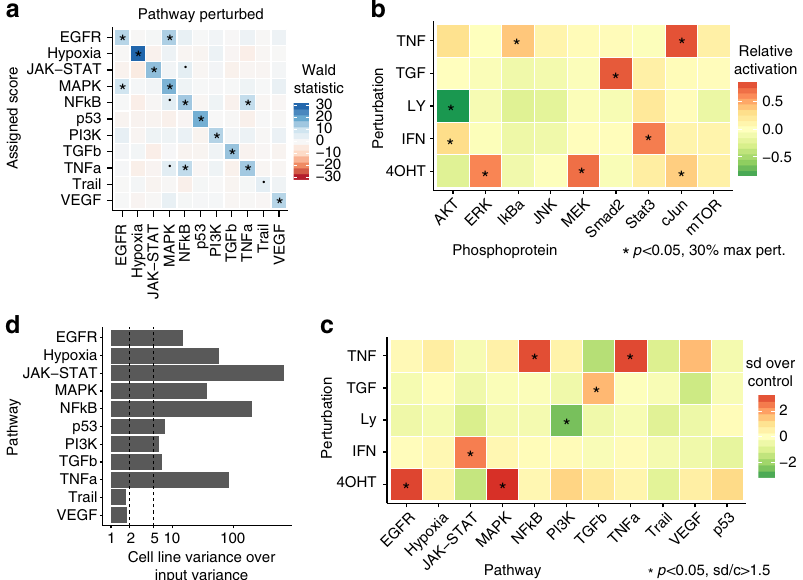
Fig. 2 Evaluation of pathway-response signatures. a Associations for PROGENy pathway scores with experimental perturbation for experiments that the model was not built with (leave-one-out cross-validation). Each pathway is strongly associated with its own perturbation, and we observe few cases of cross-talk in agreement with biological knowledge. b Pathway perturbations in HEK293 cell line activate the corresponding signaling proteins. MEK and ERK for MAPK pathway, Stat3 for Interferon-induced JAK-STAT, AKT for PI3K, Smad2 for TGFb, and IKb for TNF-alpha-induced NFkB. As expected, all increased upon stimulation except AKT that decreased upon inhibition. Activation shown relative to maximum readout per antibody, p values reported for one-sample one-sided t test. Results are signi fi cant if p < 0.05 and perturbation is at least 30% of maximum. c PROGENy correctly infers pathway activity from gene expression in the HEK293 experiments. Associations are signi fi cant if p value of two-sample one-sided t test < 0.05 and experiments are at least 1.5 standard deviations above or below the control. d Stability of basal pathway scores when bootstrapping input experiments. Bars show how much more variance in pathway scores (GDSC panel) is introduced by cell line identity over using resampled perturbation experiments in model building. Variance by cell line is over fi ve times as high for most pathways, and roughly twice as high for Trail and